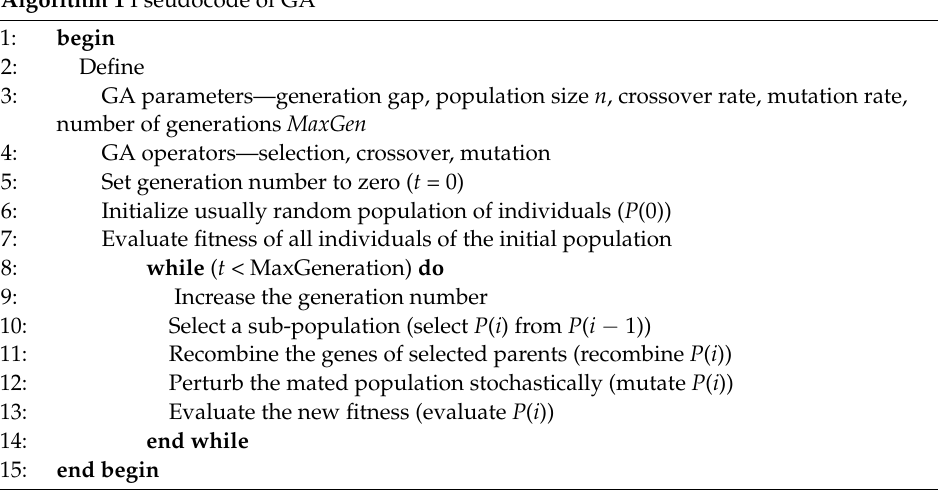
Algorithm 1 Pseudocode of GA